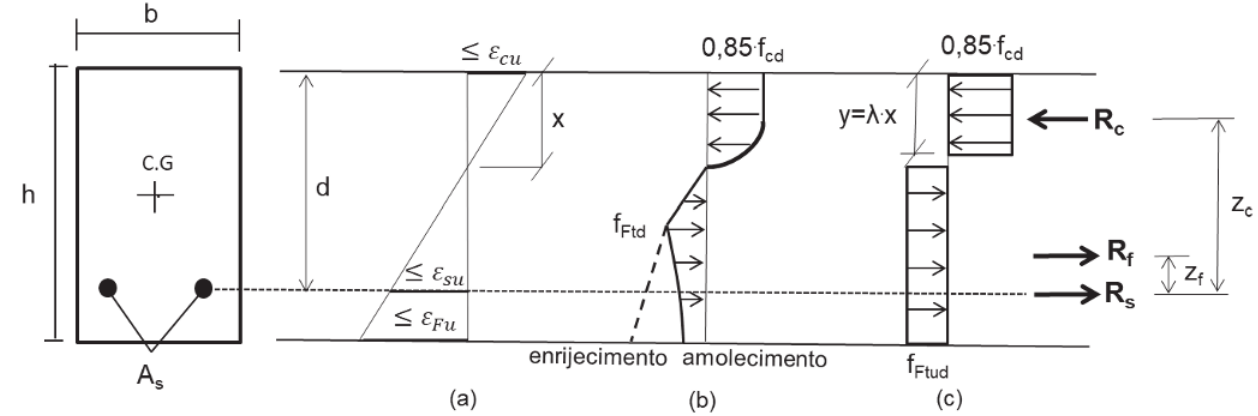
Diagrama de tensões e deformações do CARF (MC 2010): a) variação da deformação na seção transversal; b) tensões atuantes no ELS; c) tensões atuantes no